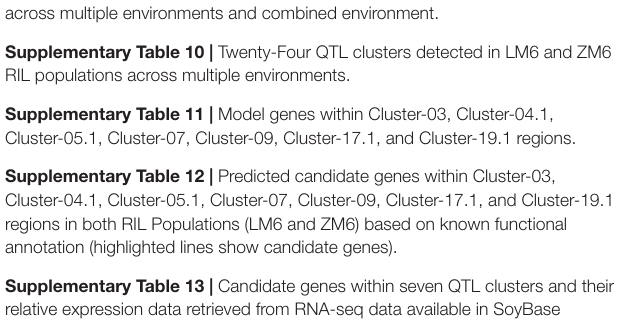
Supplementary Table 3 | Descriptive statistics, variance components, and broad-sense heritability (h 2 ) for 100-Seed weight trait evaluated in two recombinant inbred lines (RILs) LM6 and ZM6. The RILs and their parents were grown under different environments. ∗ and ∗∗ represent significance at 5 and 1%, respectively. Supplementary Table 4 | Combined analysis of variance (ANOVA) for Seed shape and size trait (SL, SW, ST, SLW, SLT, SWT, FI) in ZM6 and LM6 RIL Populations across four different environments (2012FY, 2012JP, 2014JP and 2017JP). Supplementary Table 5 | Combined analysis of variance (ANOVA) for 100-Seed weight trait in ZM6 and LM6 RIL Populations across six different environments (2012FY, 2012JP, 2013JP, 2014JP, 2014YC, and 2017JP). Supplementary Table 6 | Correlation analysis among seven Seed size/Shape traits (SL, SW, ST, FI, SLT, SLW, SWT), and 100-seed weight (HSW). ∗ and ∗∗ represent significance at 5 and 1%, respectively. Supplementary Table 7 | Main-effect quantitative trait loci (M-QTLs) identified for three seed-size traits (SL, SW, and ST in ZM6 and LM6 recombinant inbred line (RIL) populations across multiple environments and combined environment. Supplementary Table 8 | Main-effect quantitative trait loci (M-QTLs) identified for four seed-shape traits [Seed length/width ratio (SLW), Seed length thickness ratio (SLT), Seed width thickness ratio (SWT), and Flatness index (FI)] in ZM6 and LM6 recombinant inbred line (RIL) populations across multiple environments and combined environment. Supplementary Table 9 | Main-effect quantitative trait loci (M-QTLs) identified for 100-Seed weight in ZM6 and LM6 recombinant inbred line (RIL) populations across multiple environments and combined environment.